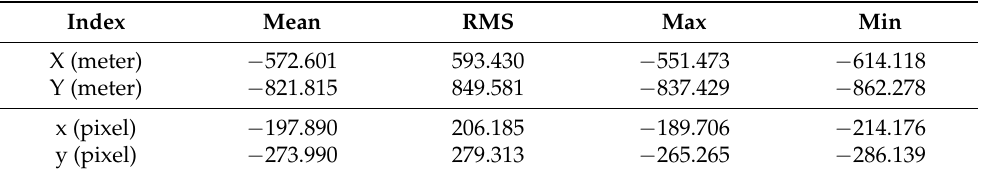
Table 3. Initial positioning accuracy of the corresponding image points on the ZY-3 three-line array camera.